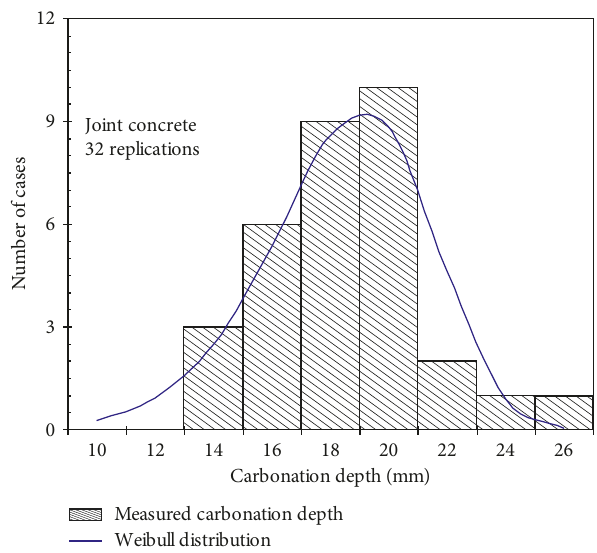
Figure 6: Distribution of carbonation depth values obtained from field data for jointed concrete.